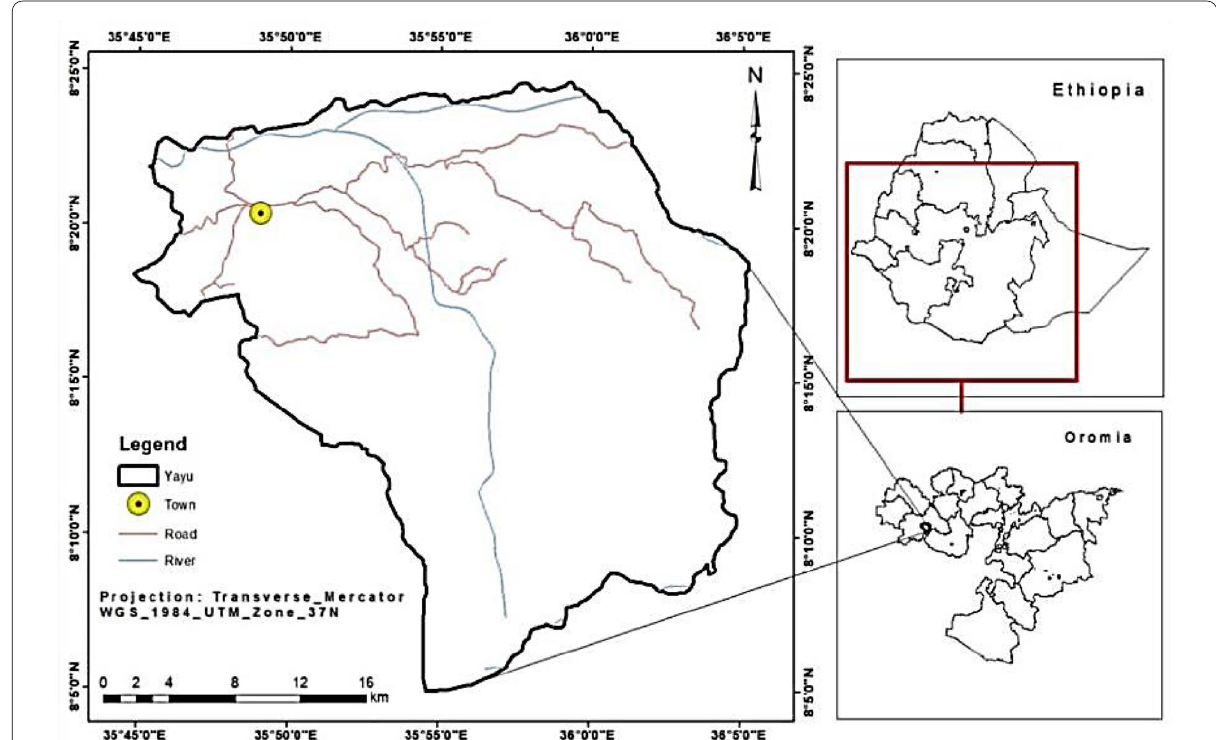
Fig. 1 Location map of the study area, Yayu forest, in the South Western region of